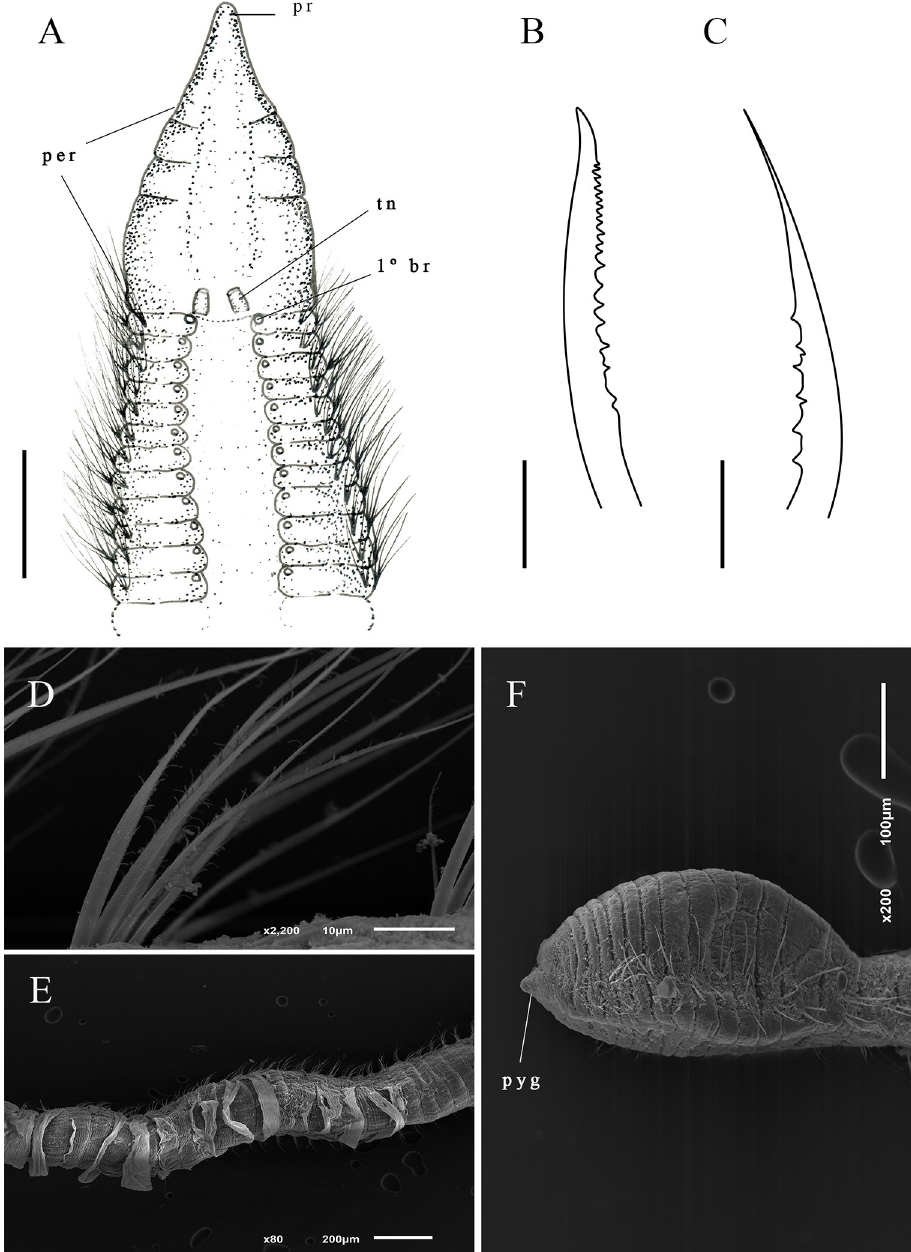
Fig 6. Kirkegaardia helenae sp. nov. (A) anterior end, dorsal view; (B) neuropodial capillary denticulated; (C) notopodial capillary denticulated; (D) capillaries in thoracic setigers with fibrils; (E) abdominal segments, dorsal view; (F) posterior end, lateral view. A–C (MNRJP-002992). Scale bars: 100 μ m (A) 200 μ m (B and C). Type locality. Atlantic Ocean: Campos Basin (Brazil). Habitat. Thin silt and clay sediments, 14 to 349 m depth. Distribution. Presently known only from Atlantic Ocean: Campos Basin (Brazil). Methyl Green. Parapodia with stain concentrated on posterior borders of noto- and neuropodia along entire body. ind., 08/01/2012, (MNRJP-002998); -19.82691667˚S -39.59519167˚W, 352 m, one ind., 28/06/ 13, (MNRJP-002999). Diagnosis. Presence of a peristomial crest along the peristomium. Peristomium with two or three annulations. Thoracic region without visible crest. Noto and neurosetae denticulated.